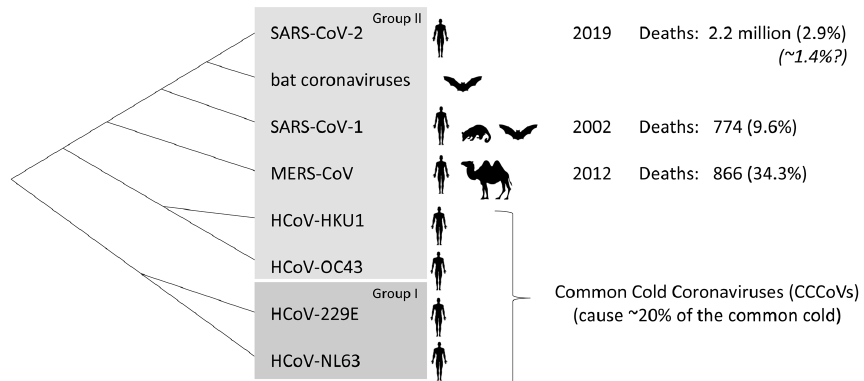
Figure 1. Cladogram of the phylogeny of coronaviruses infecting humans (Ceraolo & Giorgi, 2020; Forni et al. , 2017). Viruses closely related to SARS-CoV-2 are found in bats. Bats and civets are the probable sources of SARS-CoV-1, and camels are alternative hosts for MERS- CoV. The first reported outbreaks in people by infections with SARS-CoV-1, MERS-CoV, and SARS-CoV-2 occurred in 2002, 2012, and 2019, respectively, with differences in number of deaths and case fatality ratios among registered cases (percentages indicated in regular font between parentheses) (https://www.who.int/publications/m/item/summary-of-probable-sars-cases-with-onset-of-illness-from-1-november- 2002-to-31-july-2003 ; https://www.who.int/health-topics/middle-east-respiratory-syndrome-coronavirus-mer s; https://coronavirus.jhu.edu/ map.html ). SARS-CoV-2 infections and deaths are not always registered and based on data from New York it was estimated that the true fatality rates may be ~1.4% (Italic font) (Yang et al. ,